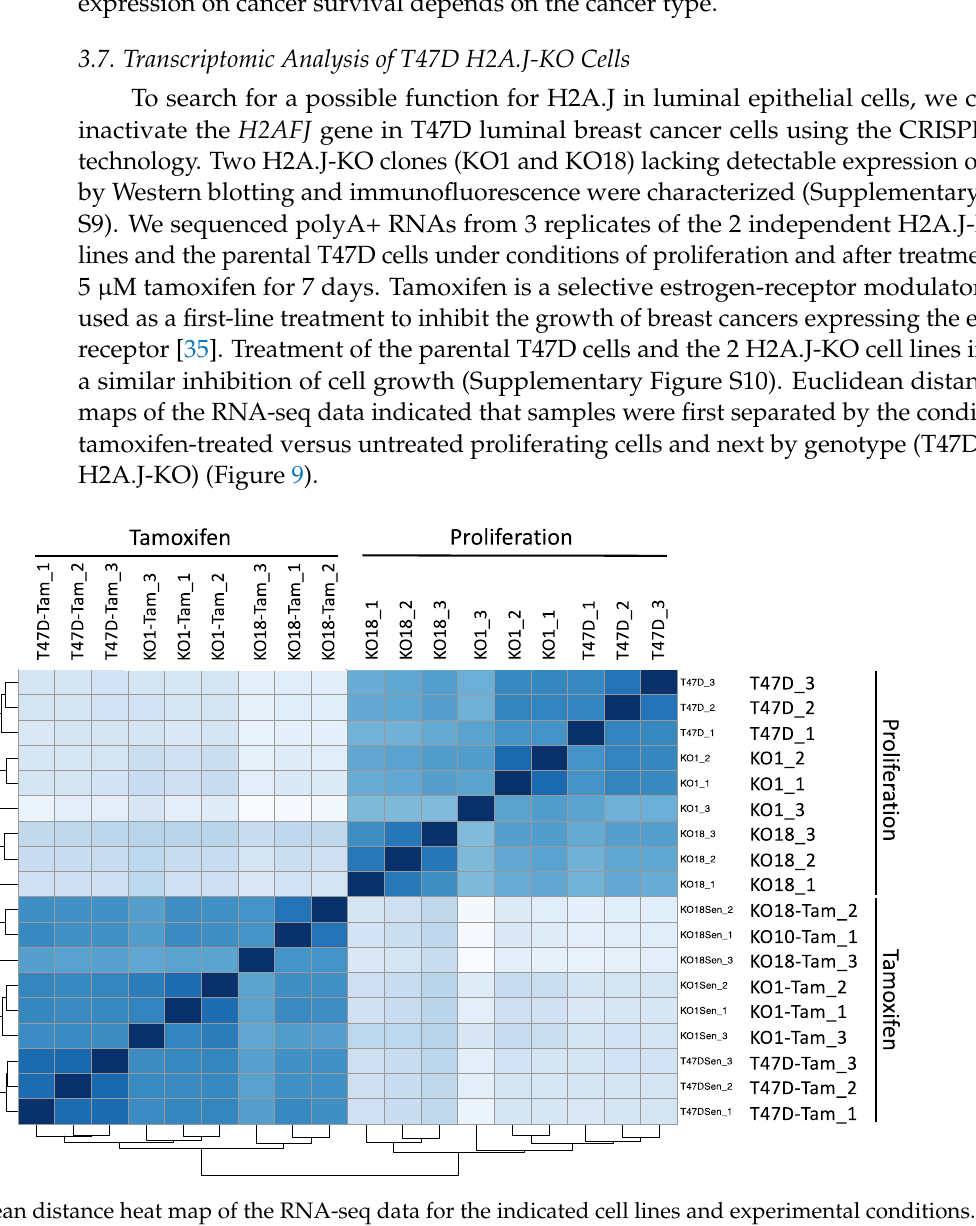
Figure 9. Euclidean distance heat map of the RNA-seq data for the indicated cell lines and experimental conditions.